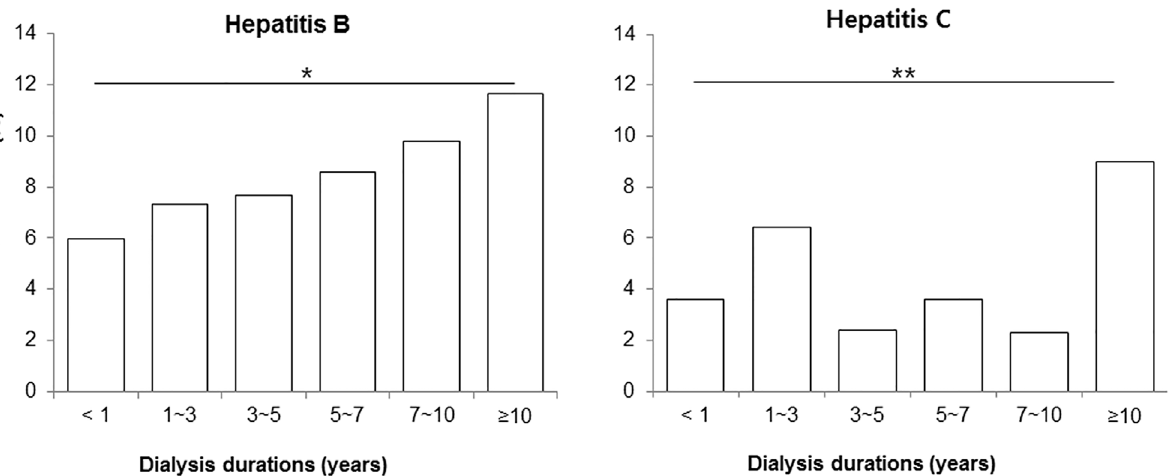
Fig 2. Prevalence of viral hepatitis infection according to dialysis vintage. Patients with dialysis vintage of (cid:1) 10 years showed significantly higher prevalences of HBV and HCV infection compared to patients with a dialysis vintage of < 1 year. * p < 0.01, ** p < 0.001 vs. group with dialysis vintage < 1